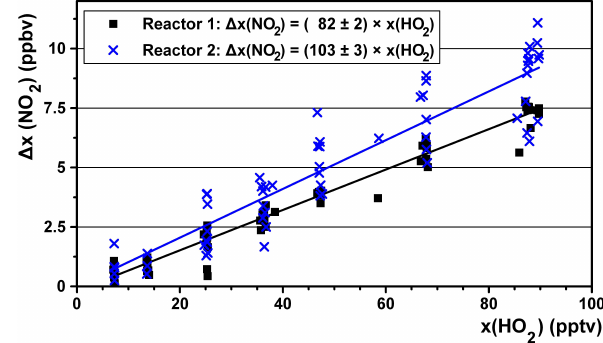
Fig. 13. Effective chain length determination corresponding to the calibration measurement shown in Fig. 11. Shown are the ∆NO 2 vs. HO 2 mixing ratios measured for both PeRCEAS reactors. The slopes of the linear fits represents their eCL .